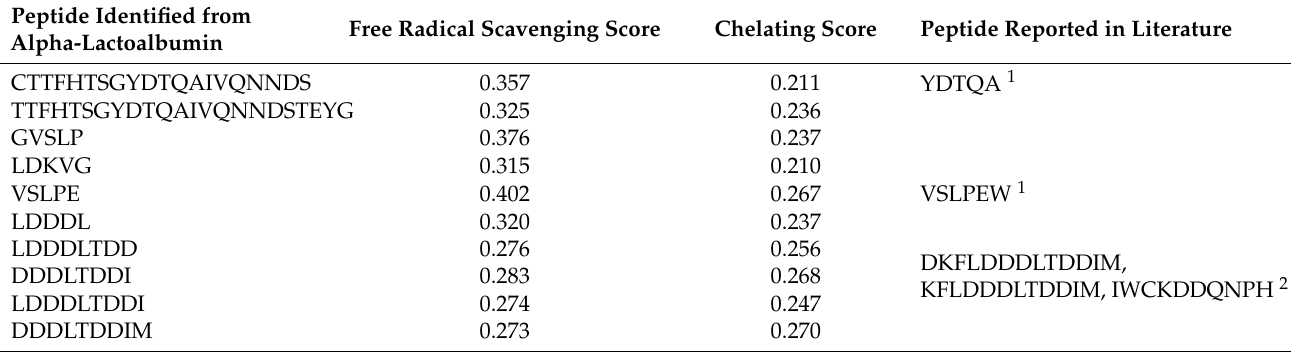
Table 6. Peptides identified from alpha-lactoalbumin.